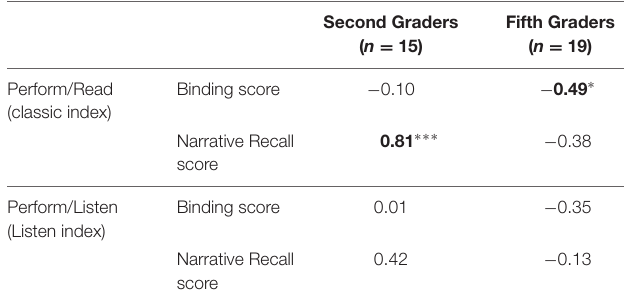
TABLE 2 | Pearson’s correlation between Enactment Indexes and cognitive scores for Second Graders and Fifth